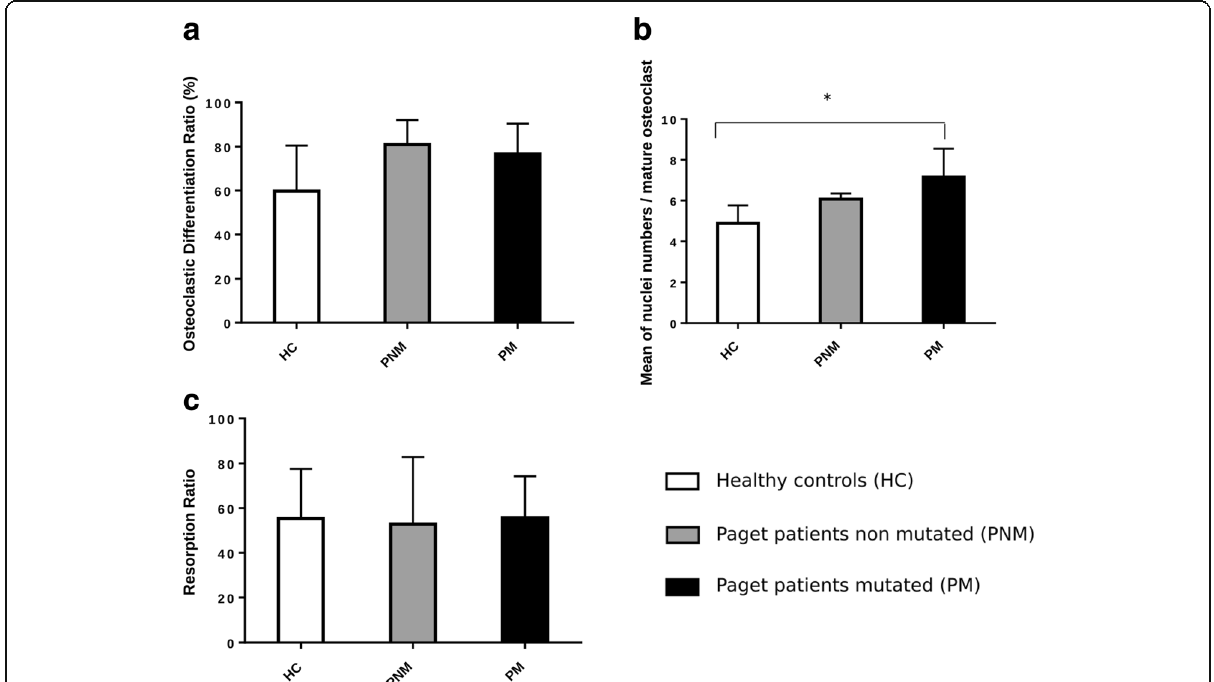
Fig. 1 In vitro differentiated osteoclast morphology and bone resorption abilities: a Percentage of multinucleated cells (MNC), defined by three nuclei or more per cell, per total number of cells with an actin ring; b Number of nuclei per MNC on 20 cells randomly selected per well; c Bone resorption abilities presented as the percentage of bone resorbed area; * p <